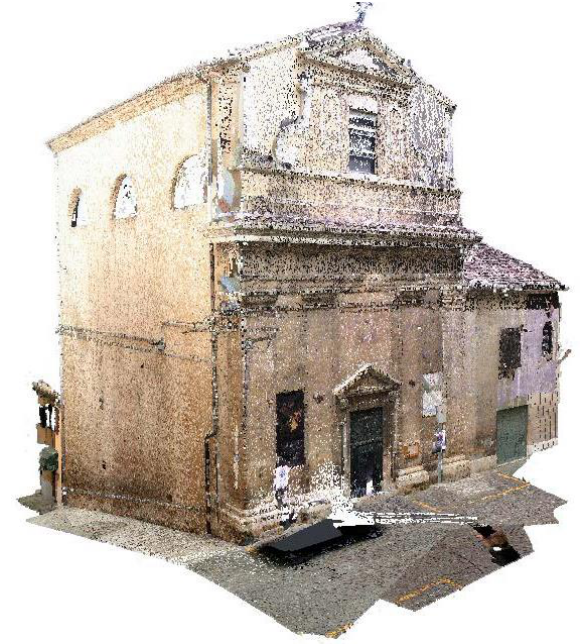
Figure 5. Points cloud textured by the images (by Onori